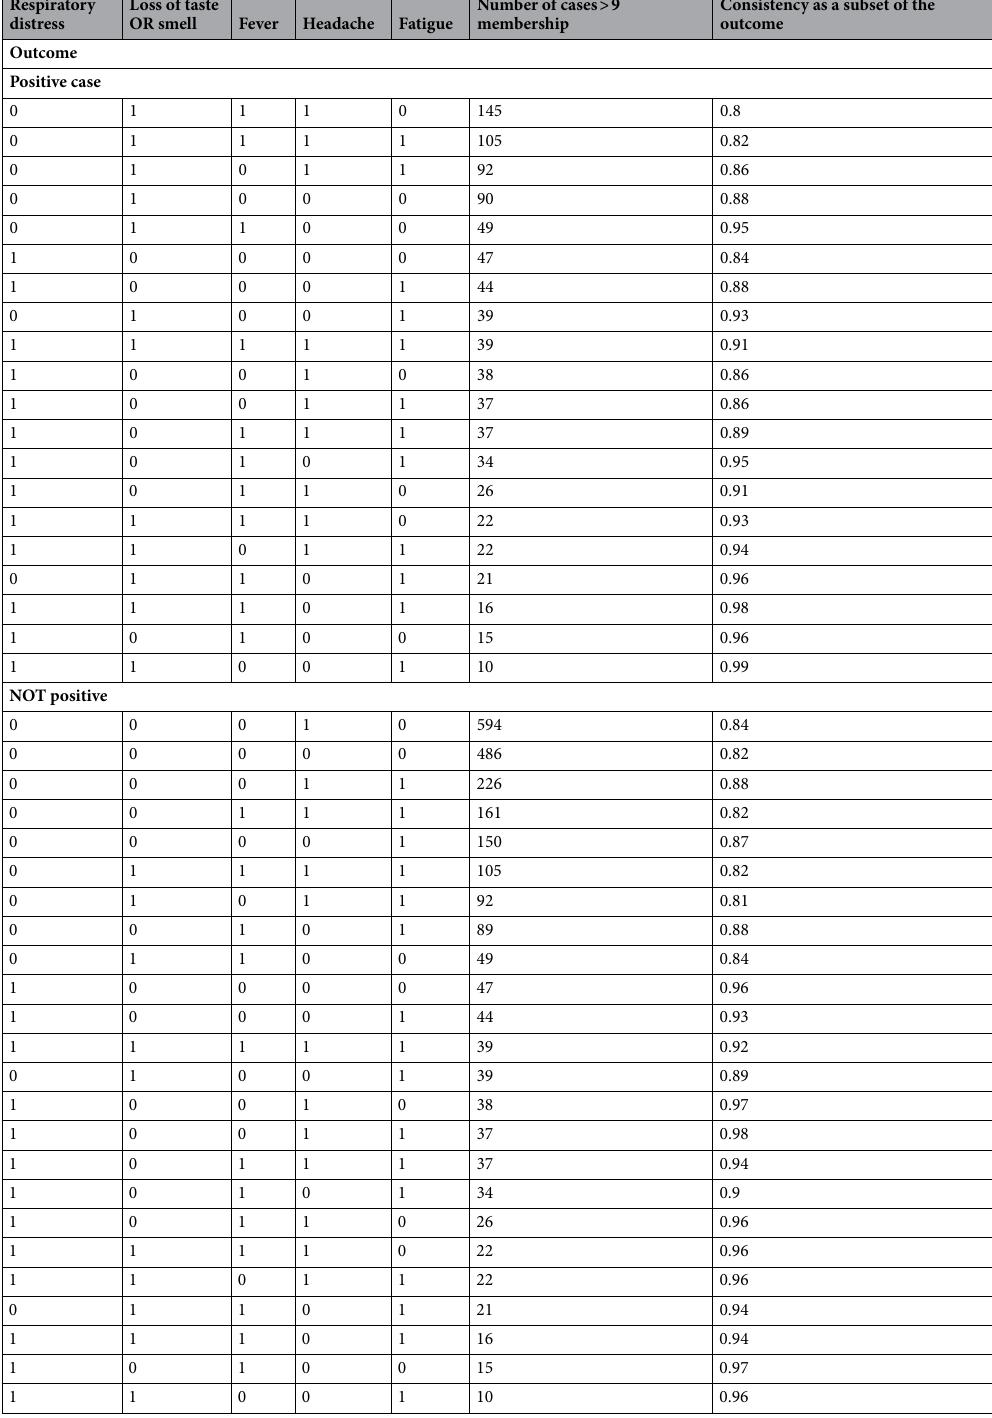
Table 1. Truth table with presence and absence of outcome “positive case”. Consistency > 0.8 and number of cases > 9